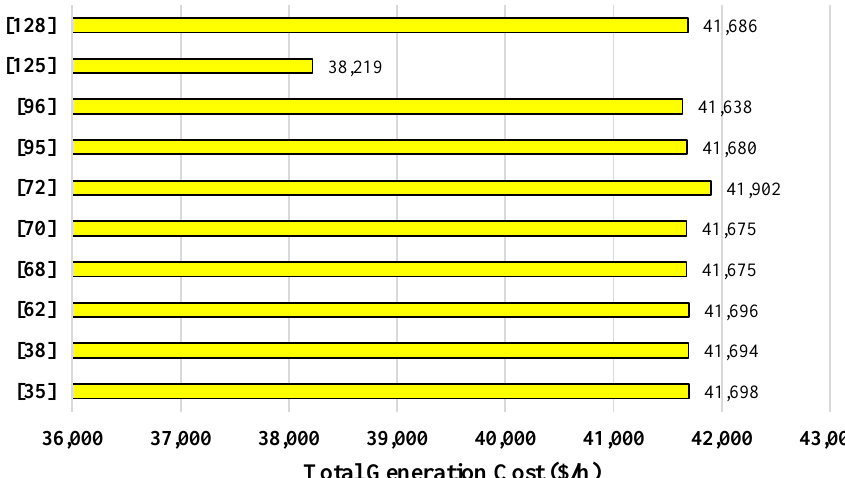
Figure 10. Comparison of cost obtained by different algorithms for IEEE 57-bus test system based on objective function (6).